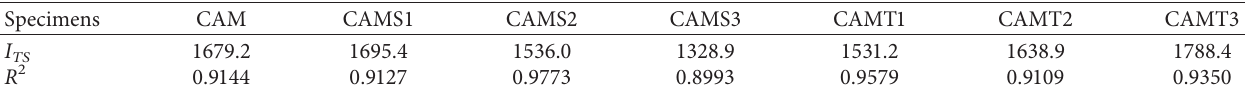
f ) and (( 1/ T ) − ( 1/ T r )) of (a) CAM, (b) CAMS1, (c) CAMS2, (d) CAMS3, (e) CAMT1, T / Tr FL Table 6: Temperature sensitivity factor of flexural strength.